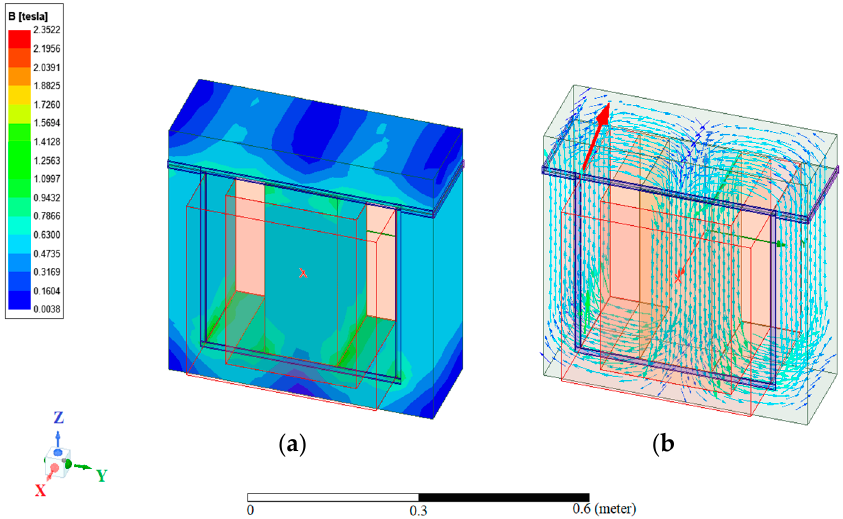
Figure 6. Flux density in the surface of the core of the BSST model ( a ) and its flux density vector representation ( b ).